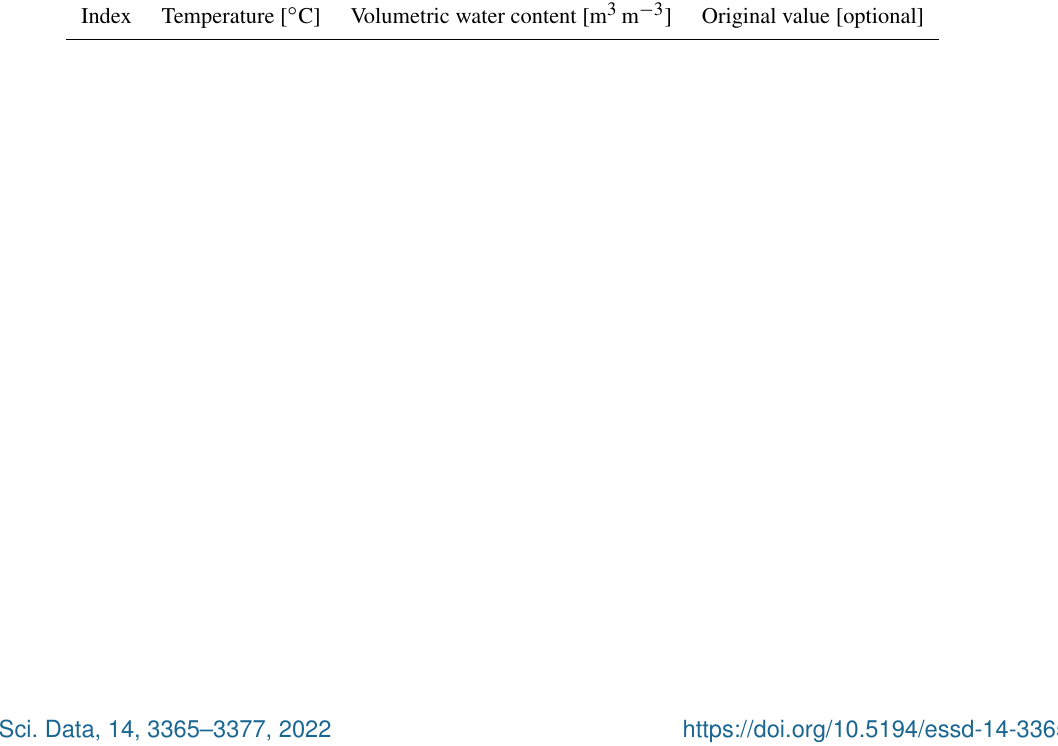
Table B1. SFCC data template. Note that if data are reported in different units, the original data are provided alongside the converted